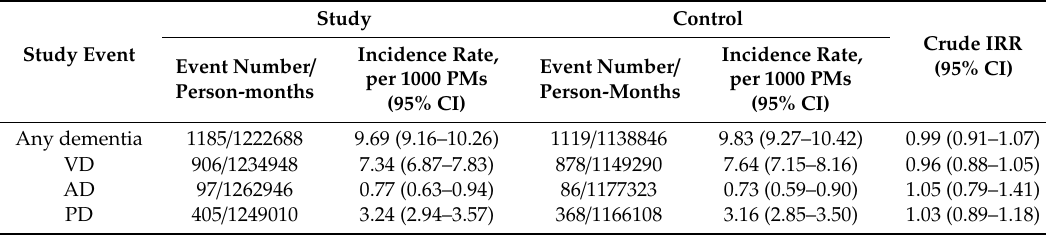
Table 2. Dementia events in the propensity score-matching study populations.